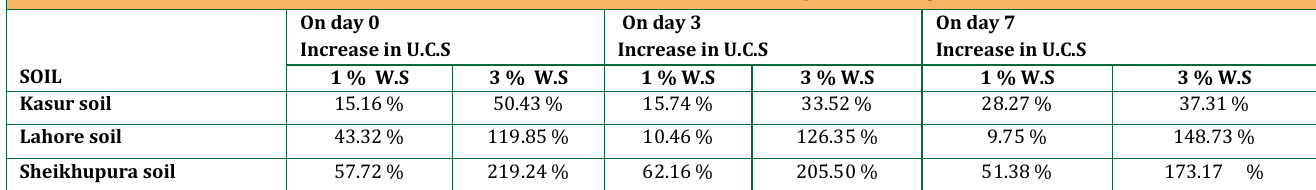
Table 2: Effect of Wheat Straw on Unconfined Compressive Strength